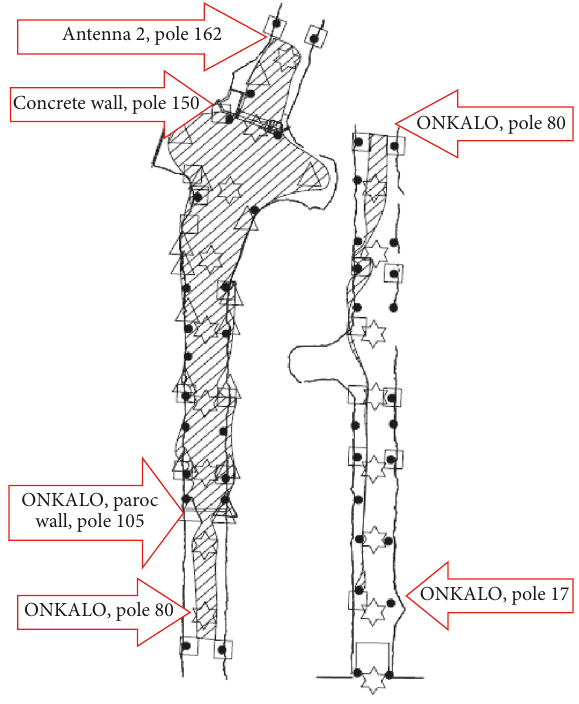
Figure 21: Antenna 2 rear reading